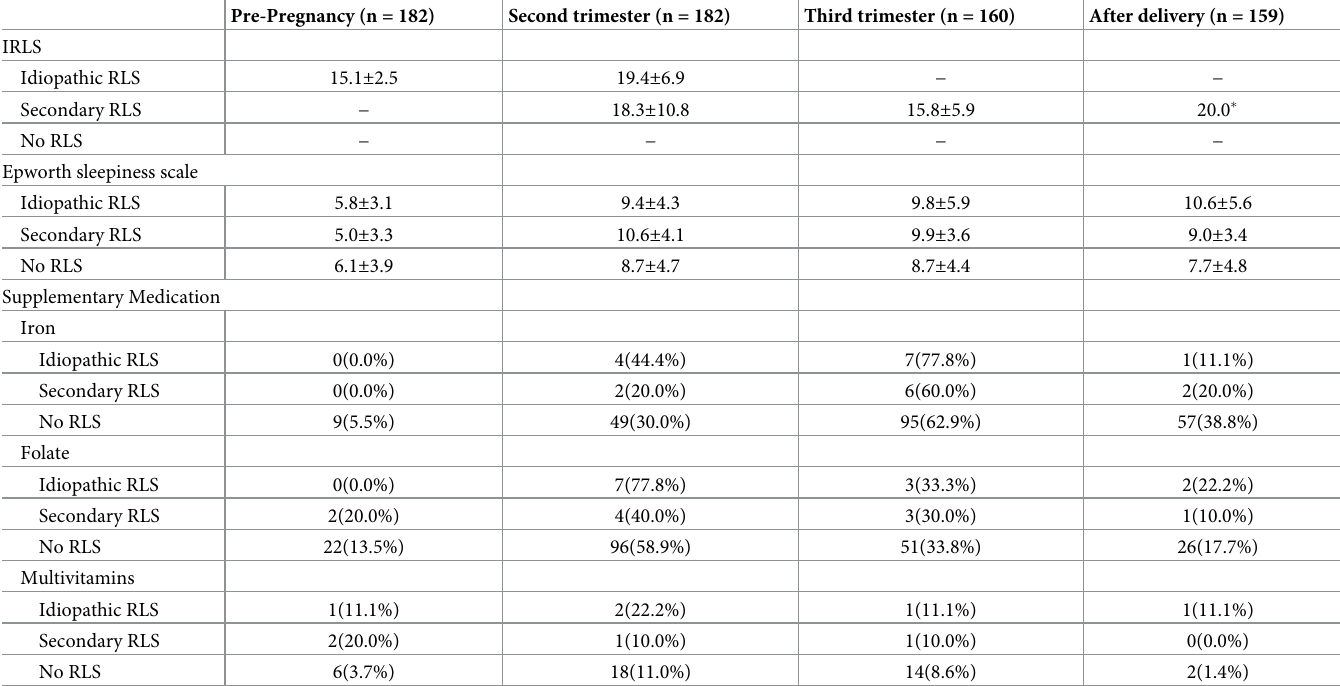
Table 3. Symptoms, severity and supplementary medication which can affect symptoms according to presence and type of restless legs